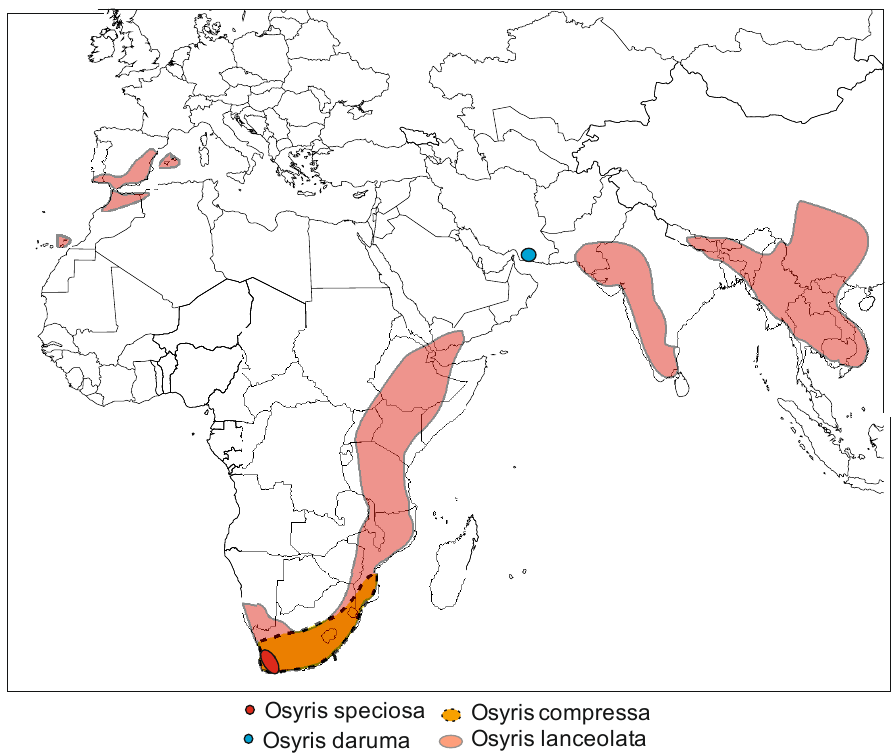
Figure 2. Global distribution of African–Asian Osyris species— Osyris alba with cross-Mediterranean distribution is not considered. Additional reports per country are given in the text.